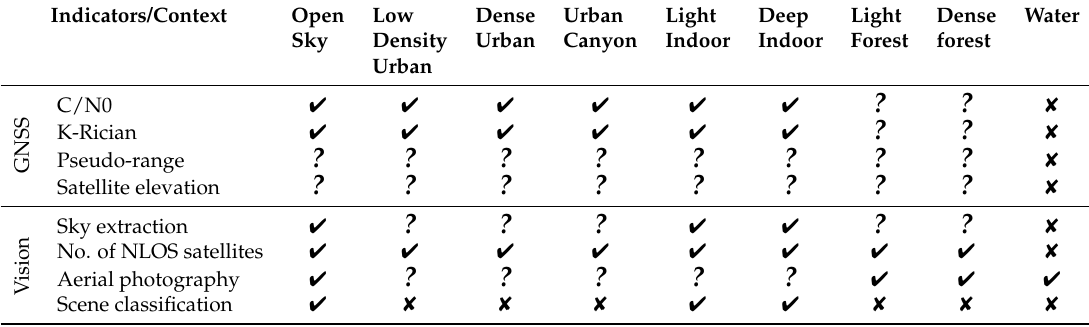
Table 5. List of the context